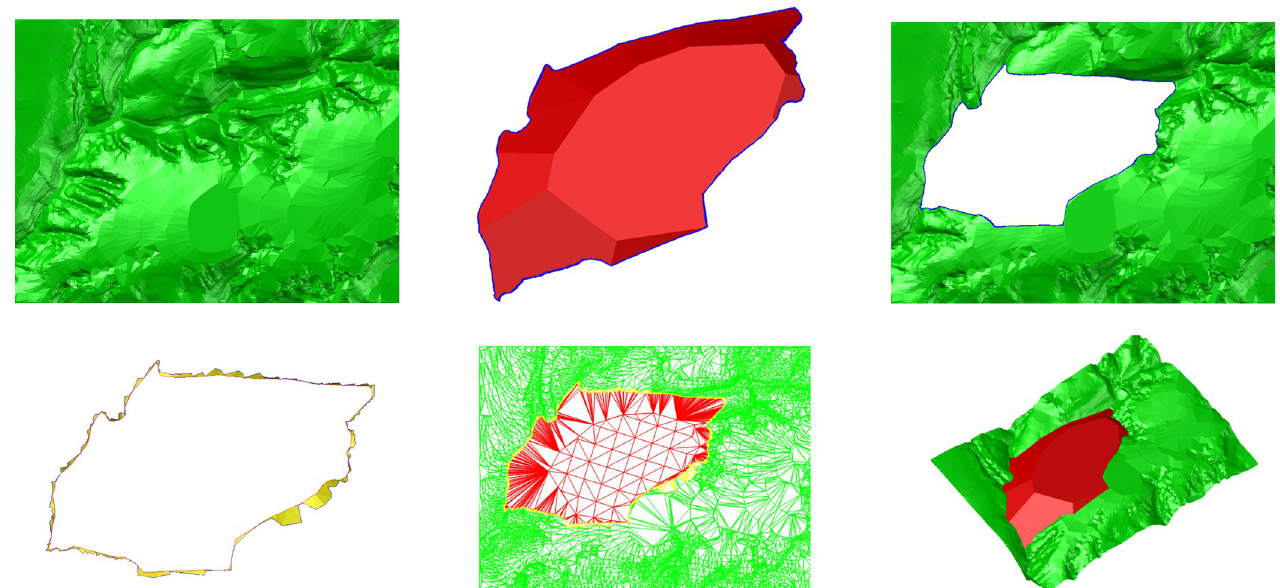
Fig 11. Digital design of the opencast coal mine’s dump site applying the precise TIN clipping algorithm.